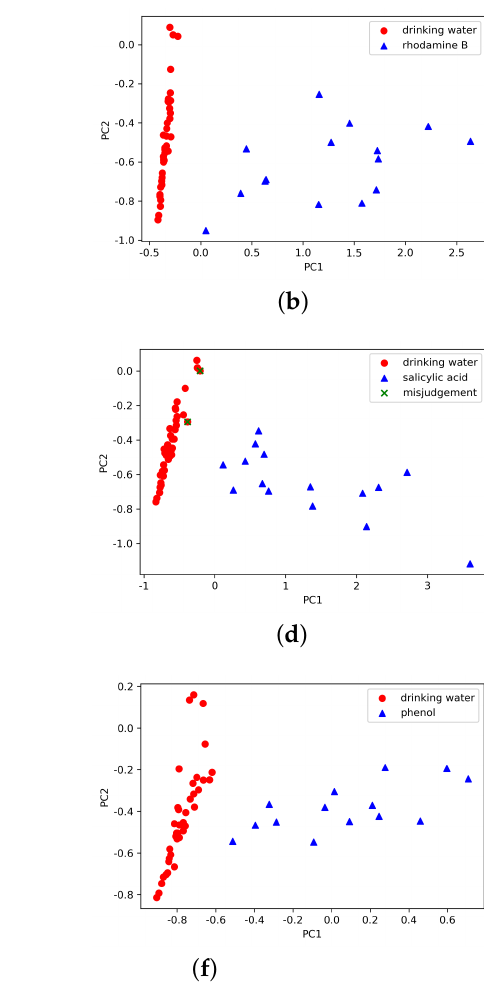
Figure 5. Identification of high concentration testing samples using multi-way decomposition methods: rhodamine B using ( a ) PARAFAC and ( b ) PCA; salicylic acid using ( c ) PARAFAC and